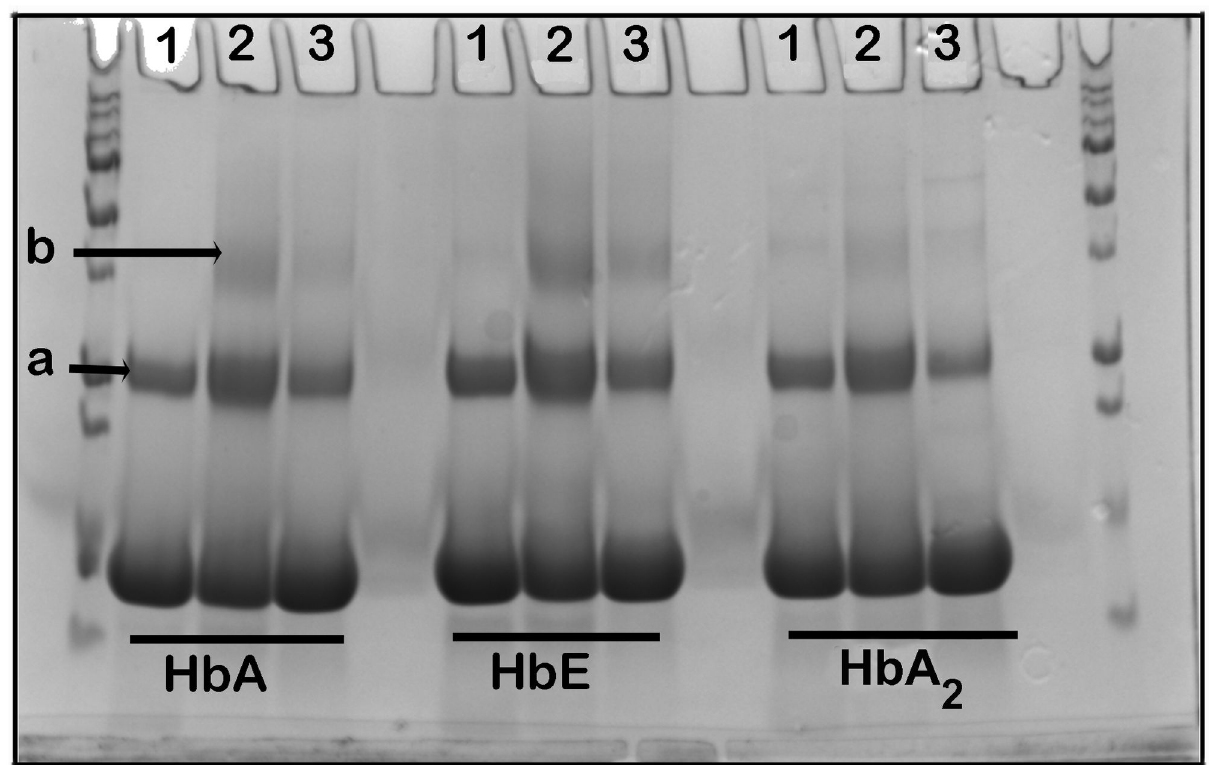
Figure 6. SDS-PAGE analysis of Hb variants (20 µg) incubated at pH 11.5 and at 40°C for 15 minutes. Lane 1 shows the control, untreated Hb. Lane 2 shows the same after incubating in 5 mM H as in Lane 2, after further incubation in 10 mM DTT for 15 minutes showing maximum yield of high molecular weight aggregates ( band a and band b ) in HbE than HbA and HbA in presence of DTT (Lane 3) indicate formation of intermolecular dityrosine.